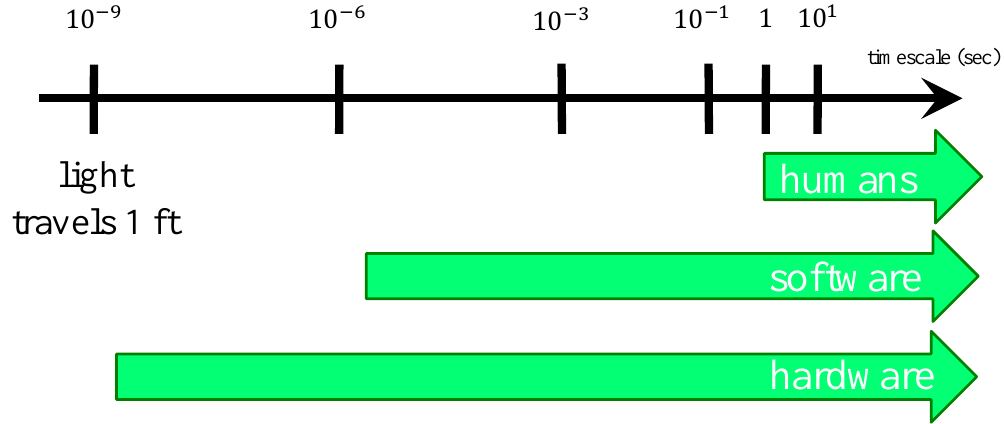
Figure 3. Schematic shows the typical timescales for human action (i.e., intervention), electronic hardware operations, and for running software including trading algorithms. The limits of electronic hardware coincide with the lower limit set by the phonon scattering time. Switching processes in typical electronic circuits determine the operating time of software algorithms. As a result, the relevant regulatory bodies face a daunting task of how to ensure system safety and (in a market setting) fairness to all participants in terms of when they receive relevant information. Moreover, regulatory bodies need to provide this reassurance without relying on any real-time human intervention during moments of potential subsecond-scale